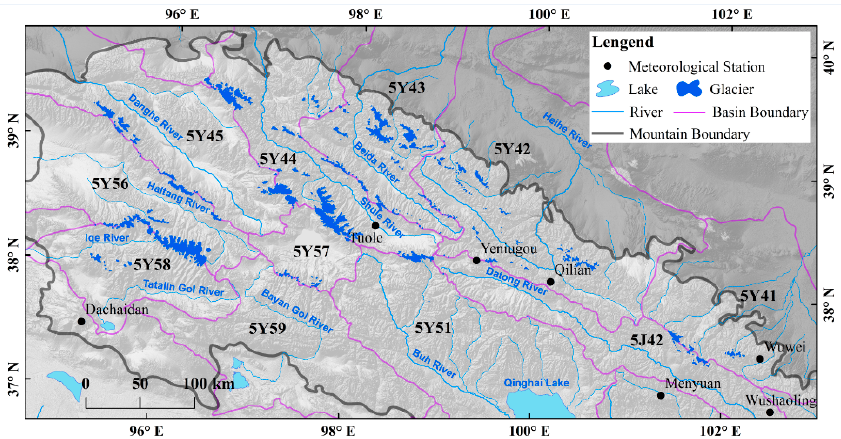
Figure 1. The glaciers distribution in the Qilian Mountains.